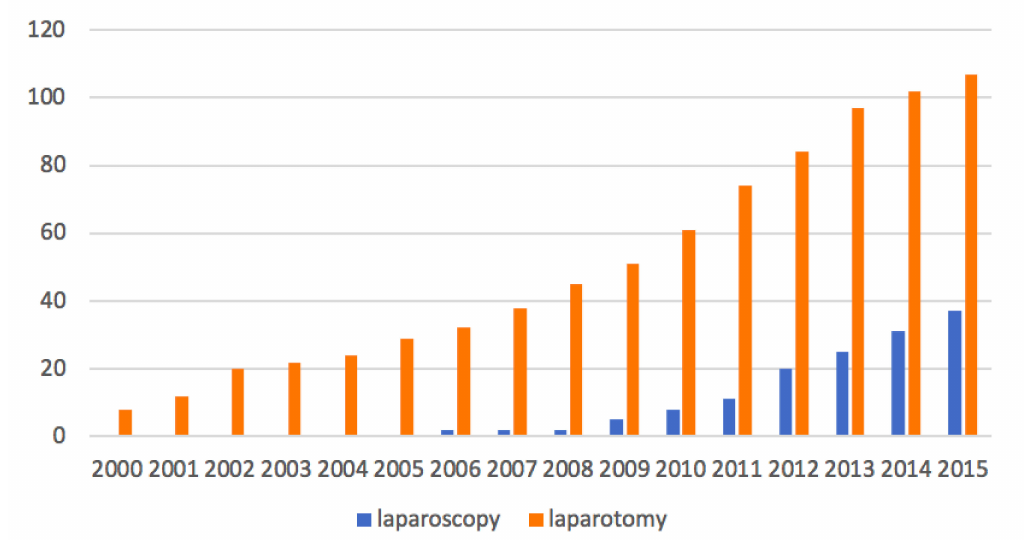
Figure 4. Distribution of patients according to the surgical route over